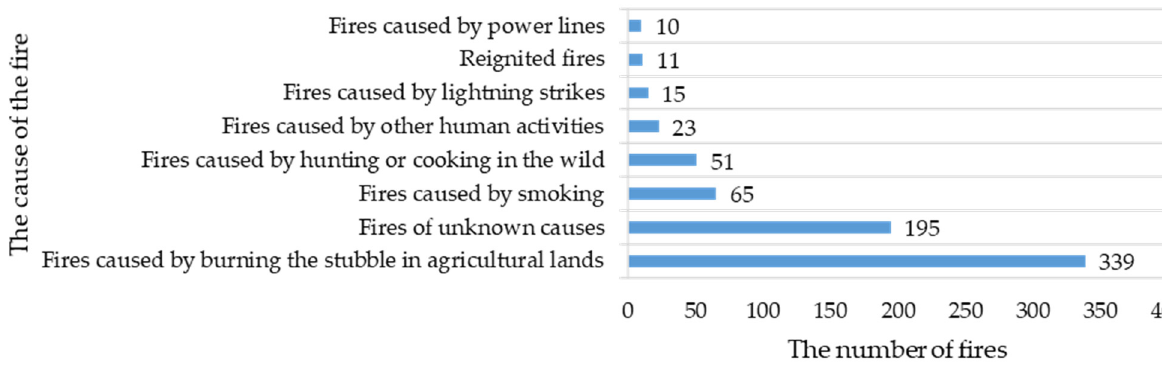
Figure 2. The cause of the fire in the study area.